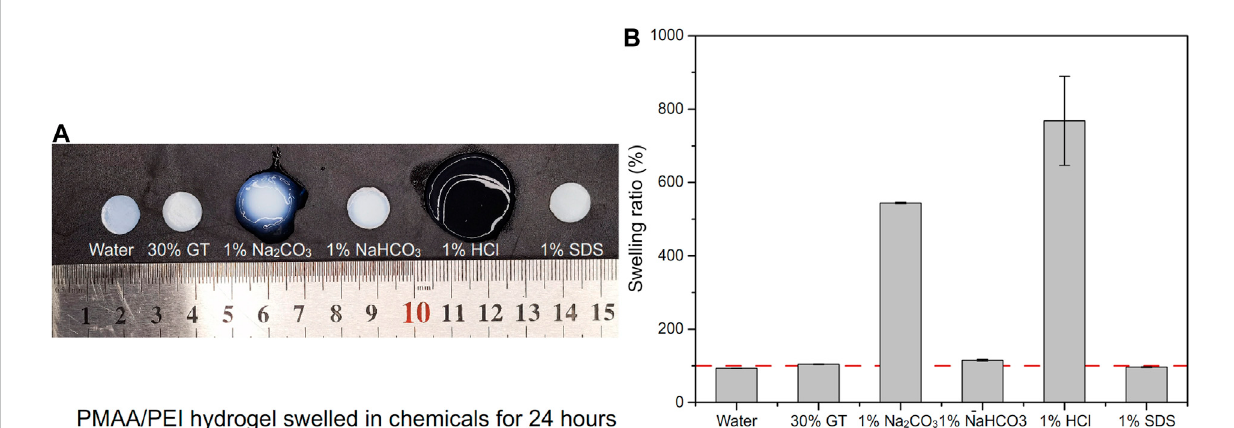
FIGURE 6 The swelling of PMAA/PEI gel in several solutions. (A) Photos of PMAA/PEI gel after swelling in water, 30% GT, 1% sodium carbonate, 1% sodium bicarbonate, 1% hydrochloric acid and 1% SDS solution for 24 h. The swelling is very obvious in hydrochloric acid and sodium carbonate solution; (B) Swelling rate data in several solutions. The gel swells severely in hydrochloric acid and sodium carbonate solutions, shrinks slightly in water and SDS, and swells slightly in 30% GT and sodium bicarbonate